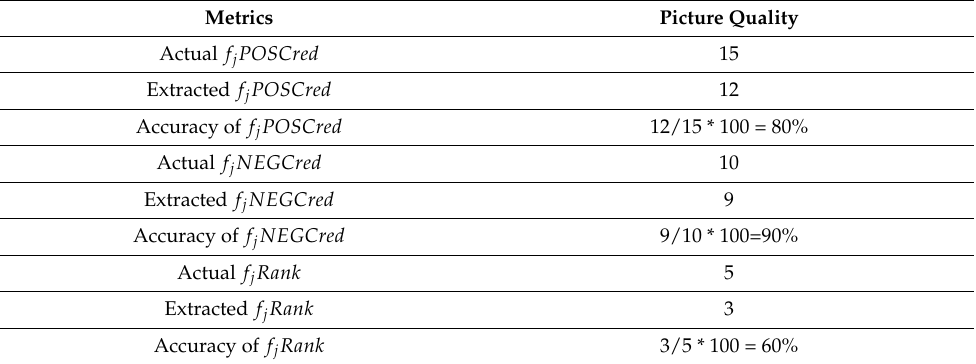
Table 3. Calculation of